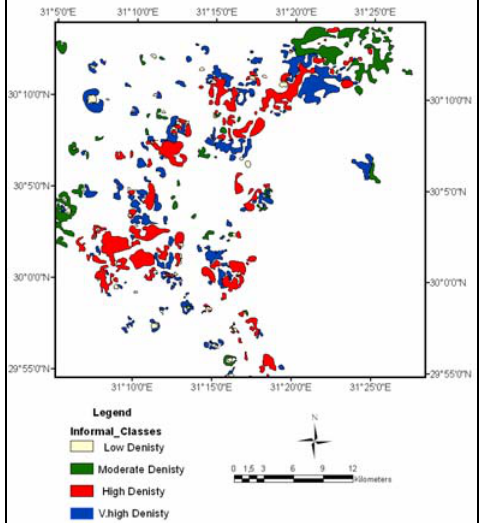
Figure. 3. The degree of changes of cultivated land based on NDVI indices